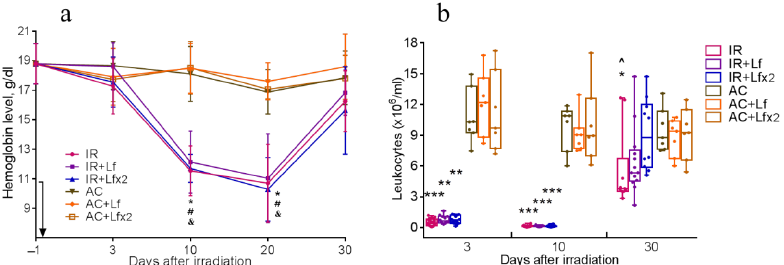
Figure 6. Dynamics of changes in the hemoglobin level ( a ) and the number of leukocytes ( b ) in the peripheral blood of mice after 7.5 Gy whole-body gamma irradiation. The arrow shows the day of irradiation. Lf (i.p.; 4 mg/mouse) was administered immediately after irradiation/sham-irradiation (IR+Lf, IR+Lf×2, AC+Lf, AC+Lf×2) and 24 h after it (IR+Lf×2, AC+Lf×2). ( a ) n = 21, 15, 15 (day − 1; for IR, IR+Lf, and IR+Lf×2, respectively); n = 9 (for AC, AC+Lf, and AC+Lf×2). * p < 0.05—IR vs. AC; # p < 0.05—IR+Lf vs. AC+Lf; & p < 0.05—IR+Lf×2 vs. AC+Lf×2 on the same day. ( b ) Each dot represents a single animal. n = 20, 15, 12 (day − 1; for IR, IR+Lf, and IR+Lf × 2, respectively); n = 7 (for AC, AC+Lf, and AC+Lf × 2). * p < 0.05, ** p < 0.01, *** p < 0.001 in comparison with the corresponding control (sham-irradiated) groups on the same day; ˆ p < 0.05 in comparison with group IR+Lf × 2 on day